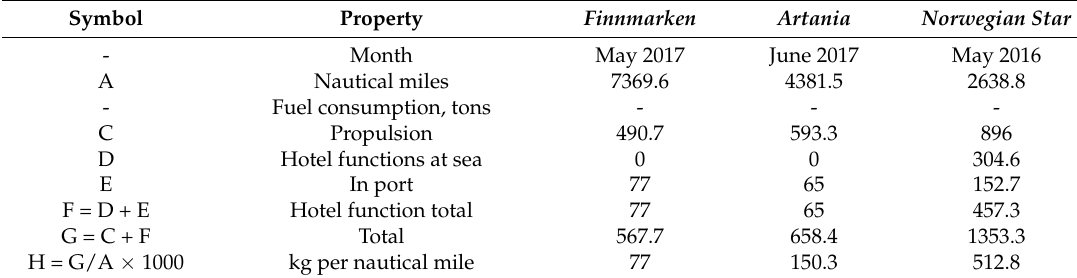
Table 13. Estimates for validation period with load and specific fuel consumption estimated from Finnmarken data.